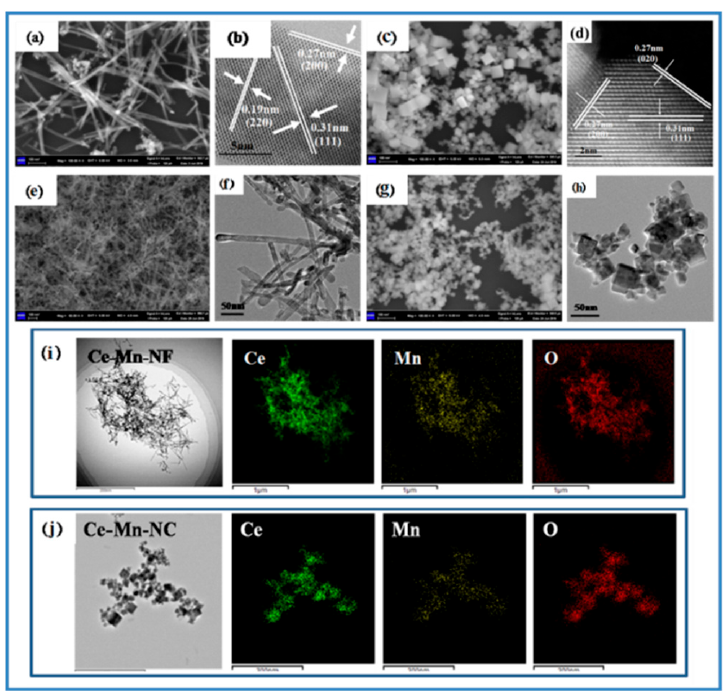
Figure 2. SEM and HRTEM images of CeO 2 -NF and CeO 2 -NC ( a – d ); SEM and TEM images of Ce-Mn-NF and Ce-Mn-NC ( e – h ); HAADF mapping images of Ce-Mn-NF and Ce-Mn-NC ( i , j ). Raman scattering was used to identify the solid solution phase, which can reflect indirectly the property of oxygen vacancy. Figure 3 shows visible Raman spectra of all the samples. In the pattern, a strong peak at ca. 460 cm − 1 and a weak one at ca. 610 cm − 1 are discerned, corresponding to the fluorite F 2g mode and a defect-induced mode (D mode), respectively [24,25]. The peaks at 275 and 1163 cm − 1 are assigned to second- order transverse and longitudinal vibration modes of cubic CeO 2 fluoride phase [26]. These bands at ca. 610 cm − 1 are usually assigned to the presence of extrinsic oxygen vacancies created as charge compensating defects during solid solution formation [27]. For Ce-Mn- NF and Ce-Mn-NC, a band at ca. 610 cm − 1 corresponds to the second-order Raman mode attributes of O 2 − vacancies formed by a low valence dopant (Mn n+ ). For pure CeO 2 , Raman band is also detected at ca. 610 cm − 1 , which is also assigned to the presence of oxygen vacancies resulted from Ce 4+ transforming to Ce 3+ . The ratio of integrated peak area of oxygen vacancy (~610 cm − 1 ) to that of main peak (460 cm − 1 ), defined as A 610 /A 460 , is